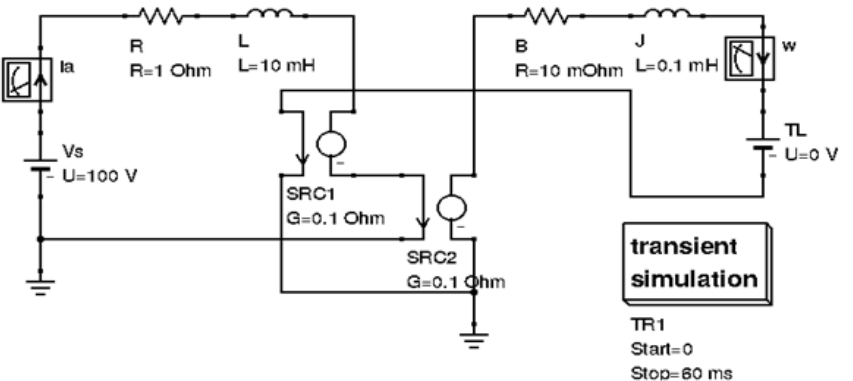
Figure 4. Equivalent circuit of a DC motor using Qucs simulator and a constant voltage supply of v s = 100